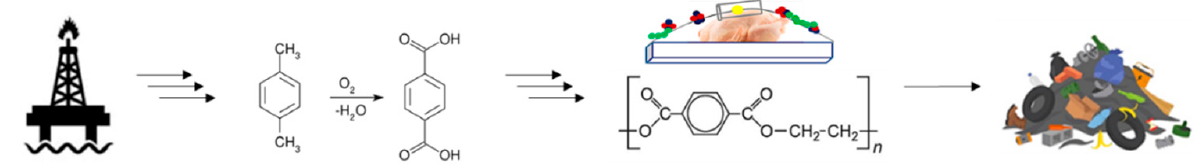
Figure 11. Linear